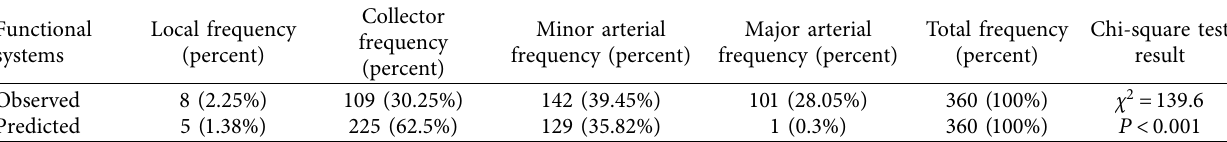
Table 8: Chi-square test based on permissible